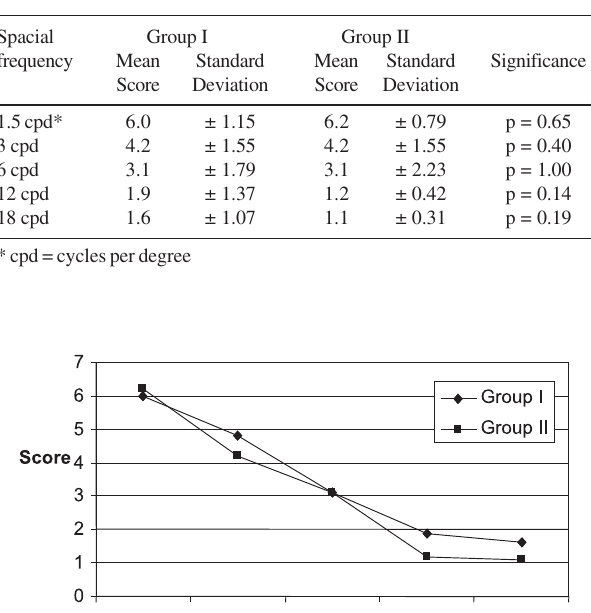
Table 4 - Comparison of the results in each spatial frequency.